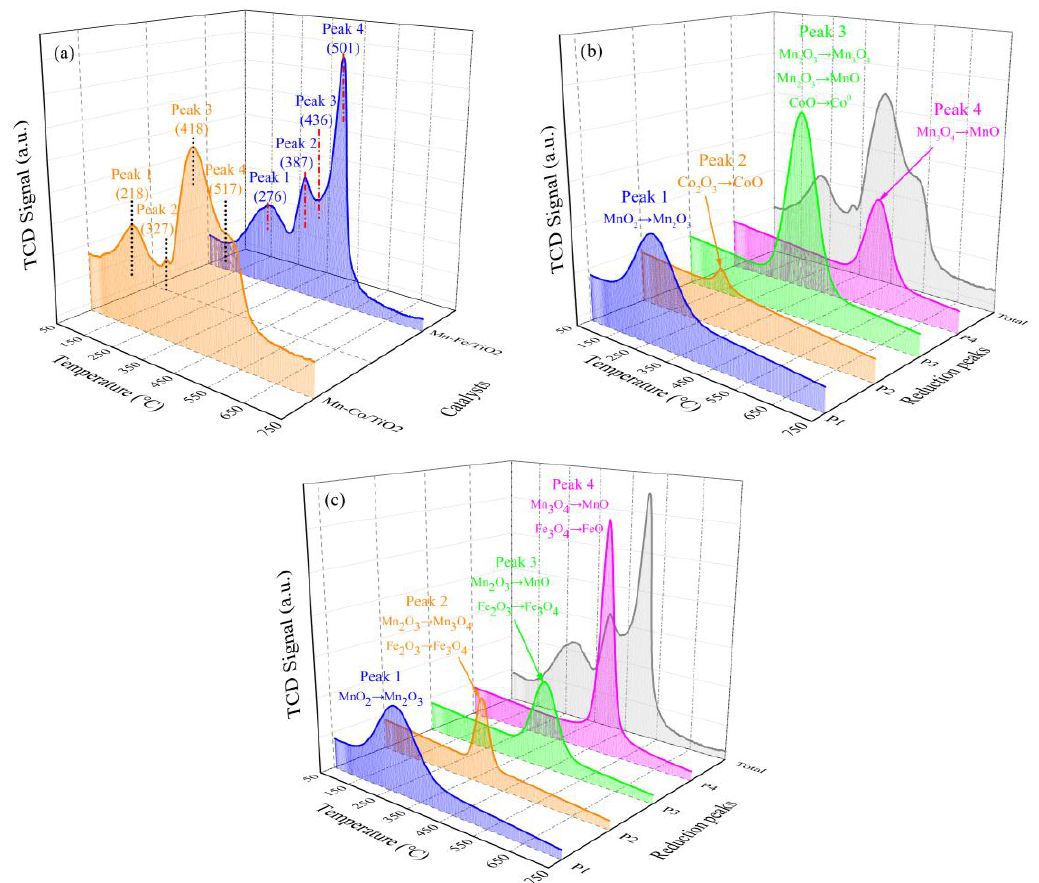
Figure 3. H 2 -TPR profiles of Mn − Co/TiO 2 and Mn − Fe/TiO 2 nanocatalysts: ( a ) Total H 2 -TPR curves; ( b ) Multi-peaks Gaussian fitting for Mn − Co/TiO 2 nanocatalyst; ( c ) Multi-peaks Gaussian fitting for Mn − Fe/TiO 2 nanocatalyst.